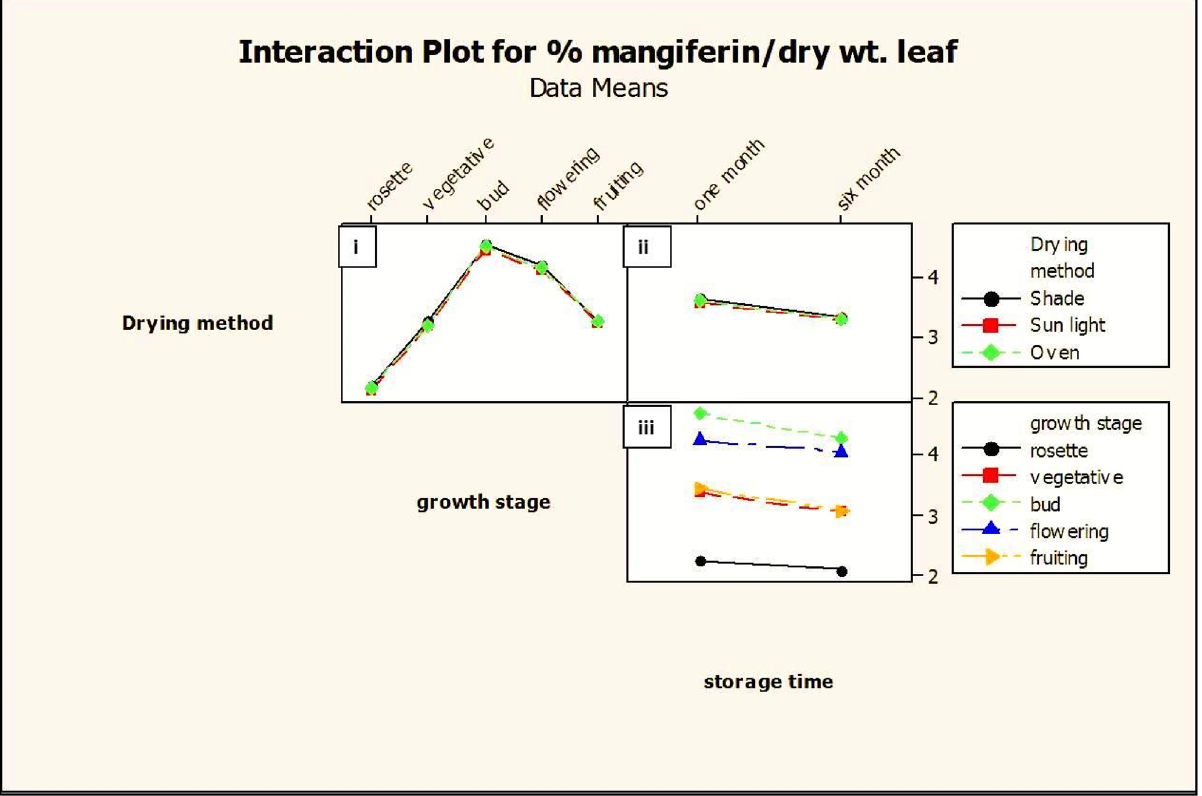
Figure 7. Interaction plot of growth stage, drying method and storage period for mangiferin yield from Swertia chirata leaves. Dot is the mean value of mangiferin